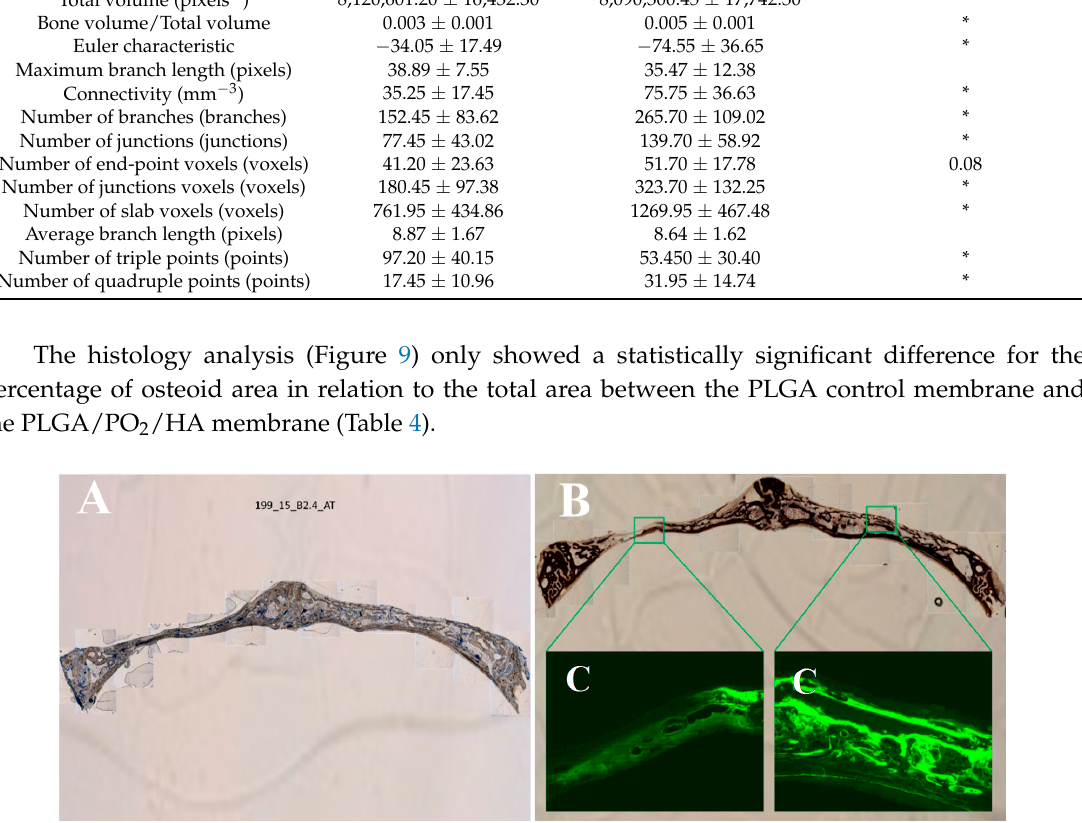
Table 4. Histomorphometric study.